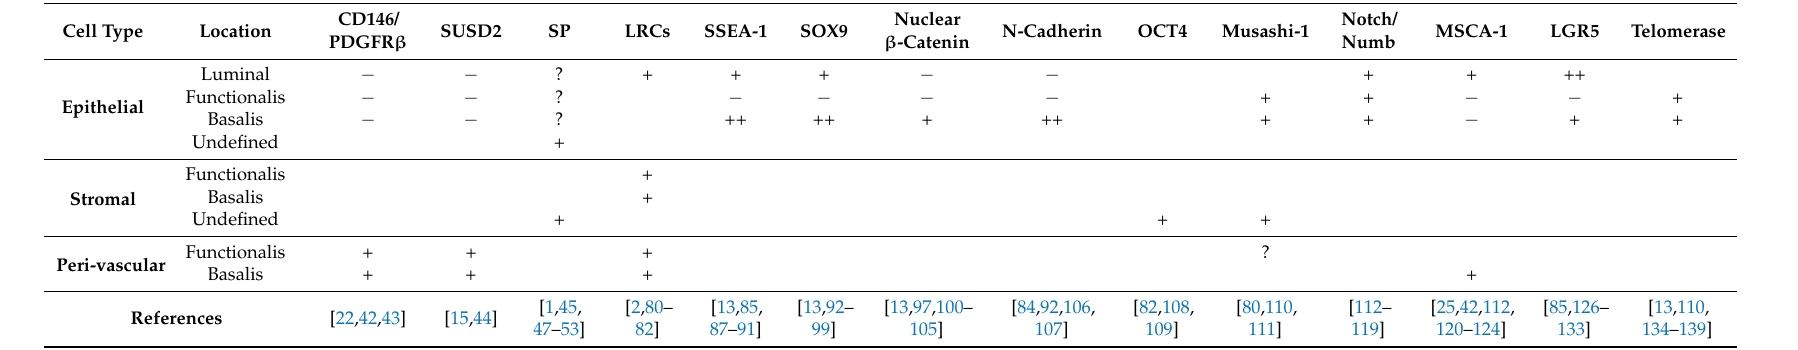
Table 1. Summary of postulated endometrial stem cell markers in epithelial, stroma, and perivascular cell